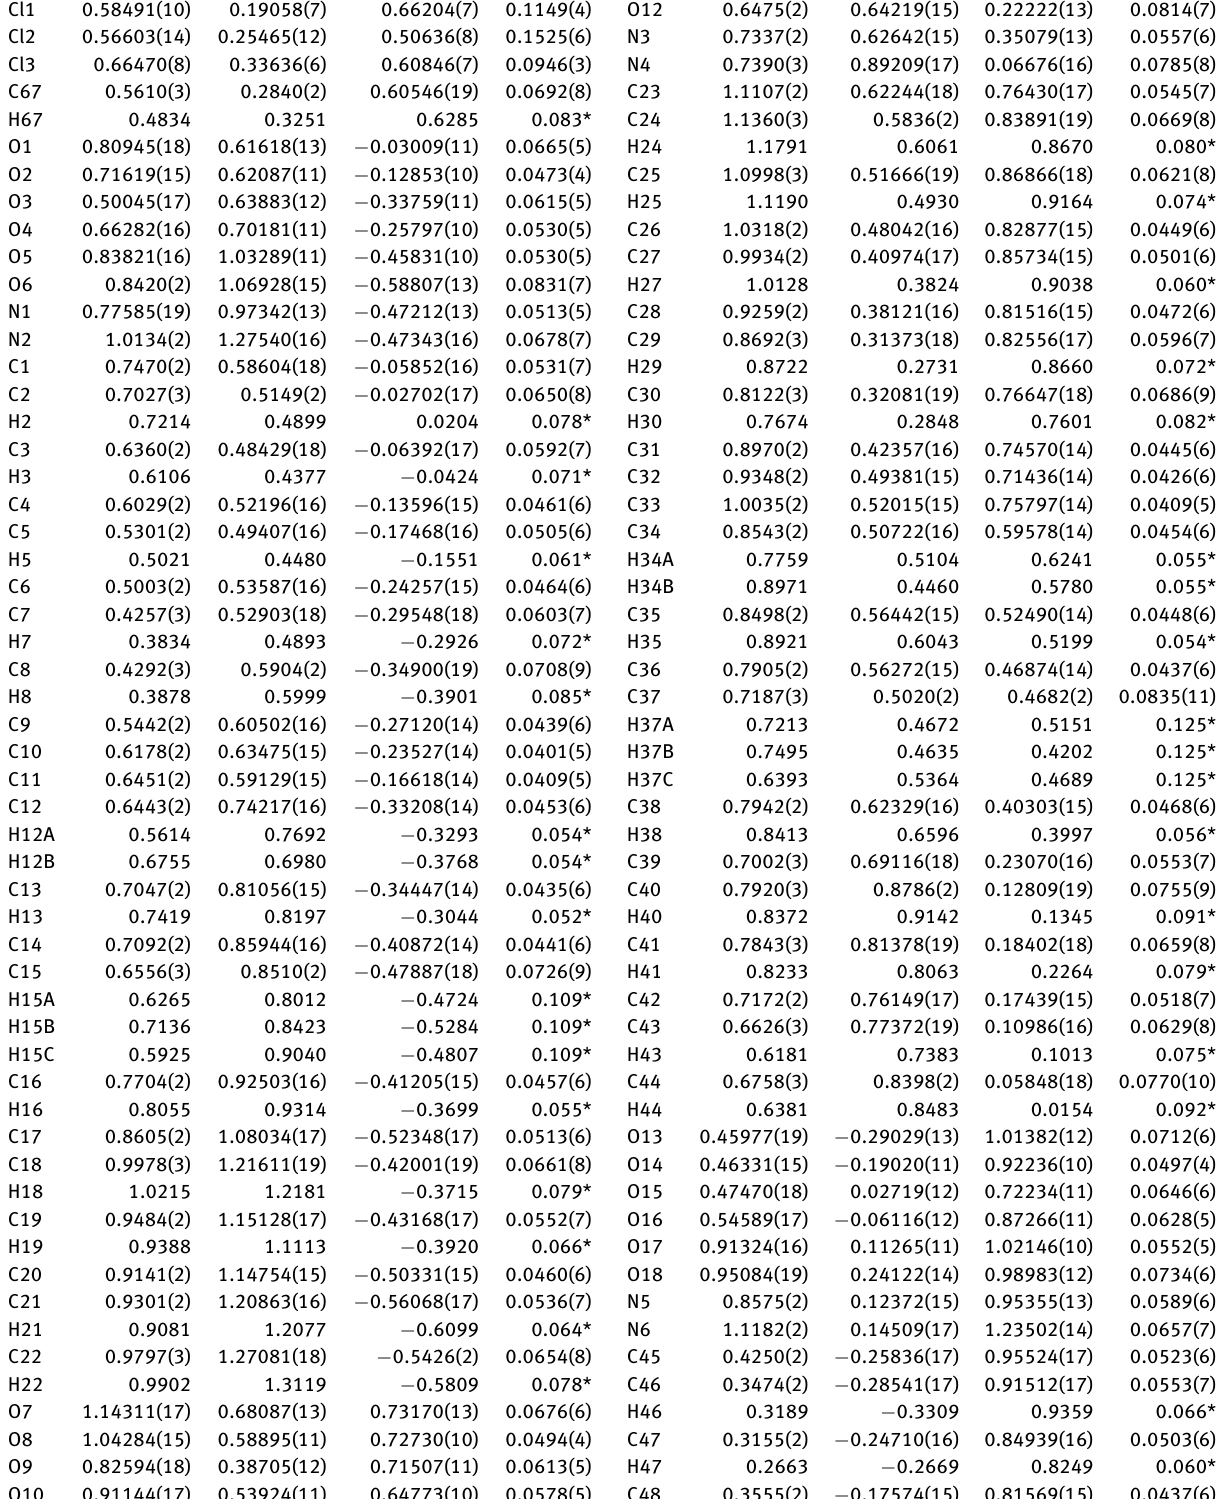
Table 2: Fractional atomic coordinates and isotropic or equivalent isotropic displacement parameters (Å 2